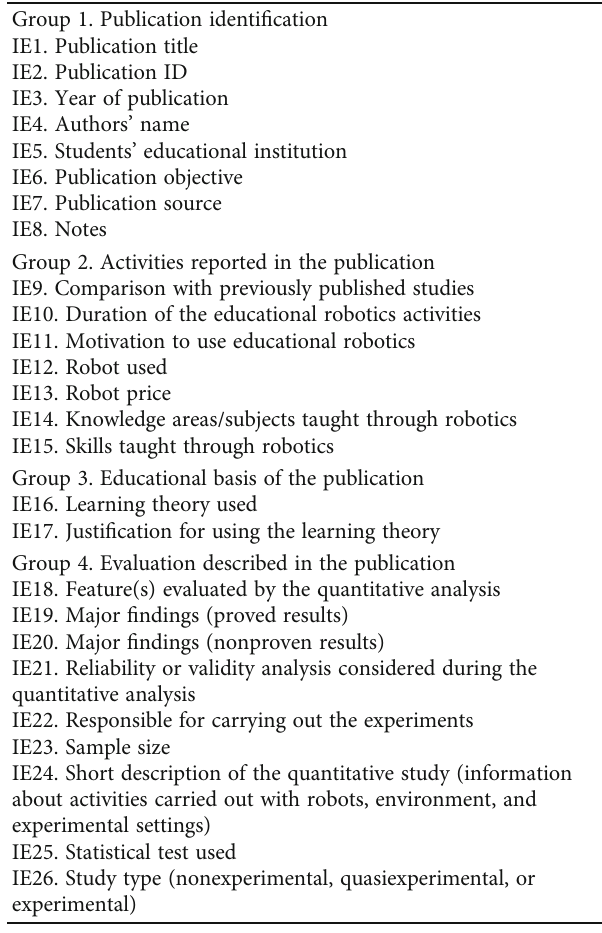
Table 3: Quality criteria (Table 3 is reproduced from Spolaor et al. 2017